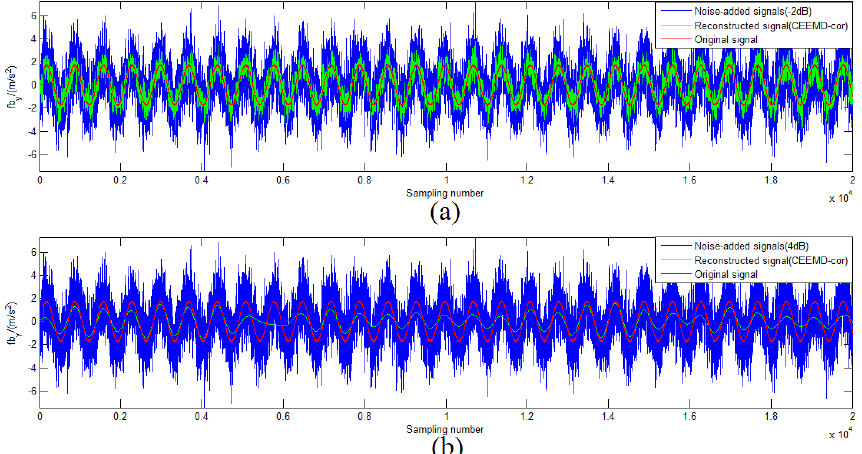
Figure 3. Reconstructed signals for the different noise signals: ( a ) − 2-dB SNR noise signals; ( b ) 4-dB SNR noise